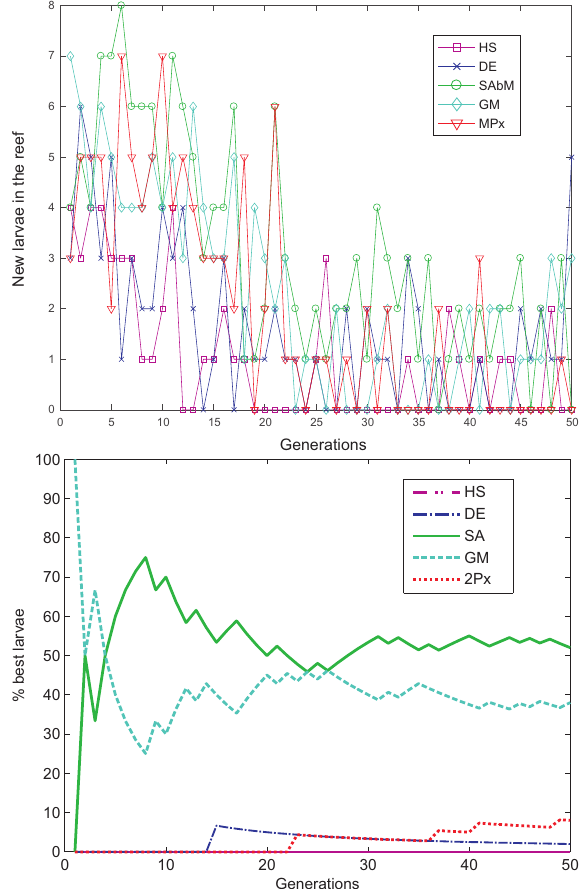
Figure 14. Evolution of the number of new larvae that are able to get into the reef per generation and substrate and the percentage of the best larvae obtained from each substrate, in the best run of the CRO-5SL algorithm: ( Top ) number of new larvae in the reef; ( Down ) percentage of best larvae